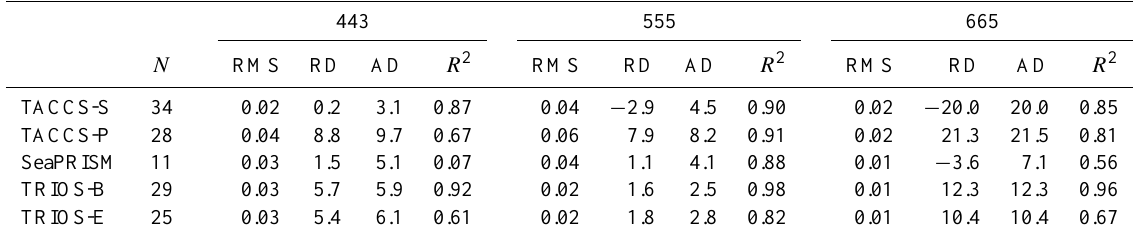
Table 11. As in Table 10 but for E d (0 + ,λ) .